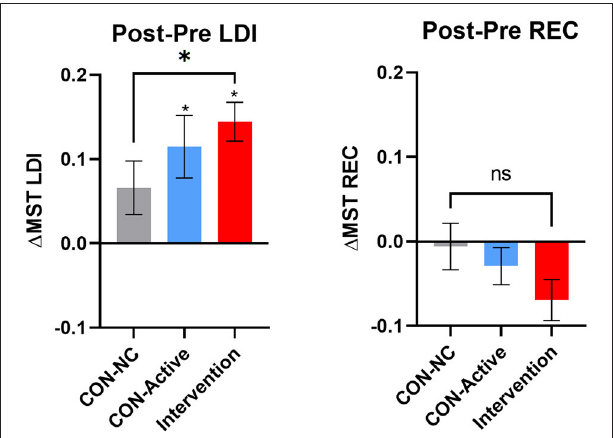
FIGURE 2 | Change in the MST’s LDI (left) and REC (right) measures for the no-contact control (CON-NC, gray), active control (CON-Active, blue), and intervention (red) groups. Error bars represent SEM. A reliable improvement in memory ability was found in the primary endpoint (LDI measure for CON-NC vs. Intervention, p < 0.05). In addition, in both the CON-Active and intervention conditions, the improvement in LDI was reliably above chance (*over individual bars, p ’s < 0.01,